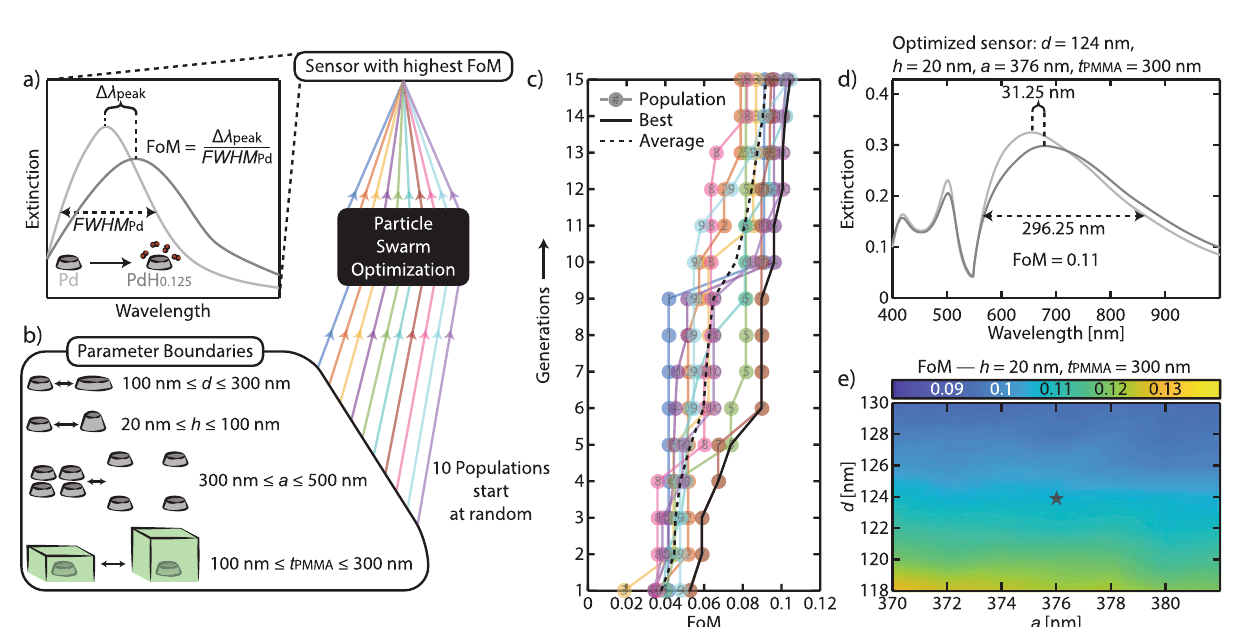
Fig. 3 | Finding the sensor parameters with the highest FoM through particle swarm optimization. a Schematic of the working principle and the associated fi gure-of-merit, FoM, of our plasmonic sensor. b Sketches of the four parameters de fi ning the architecture of the Pd nanodisk arrays and their range used for the particle swarm optimization (PSO) algorithm. In this four-dimensional searching space, 10 populations are generated at random and let evolve iteratively through the PSO algorithm to fi nd a sensor with the highest FoM, as de fi ned in ( a ). c Evolution of the FoM for each of the 10 populations through 15 iterative gen- erations. Clearly, in each generation, each population fi nds structures with higher